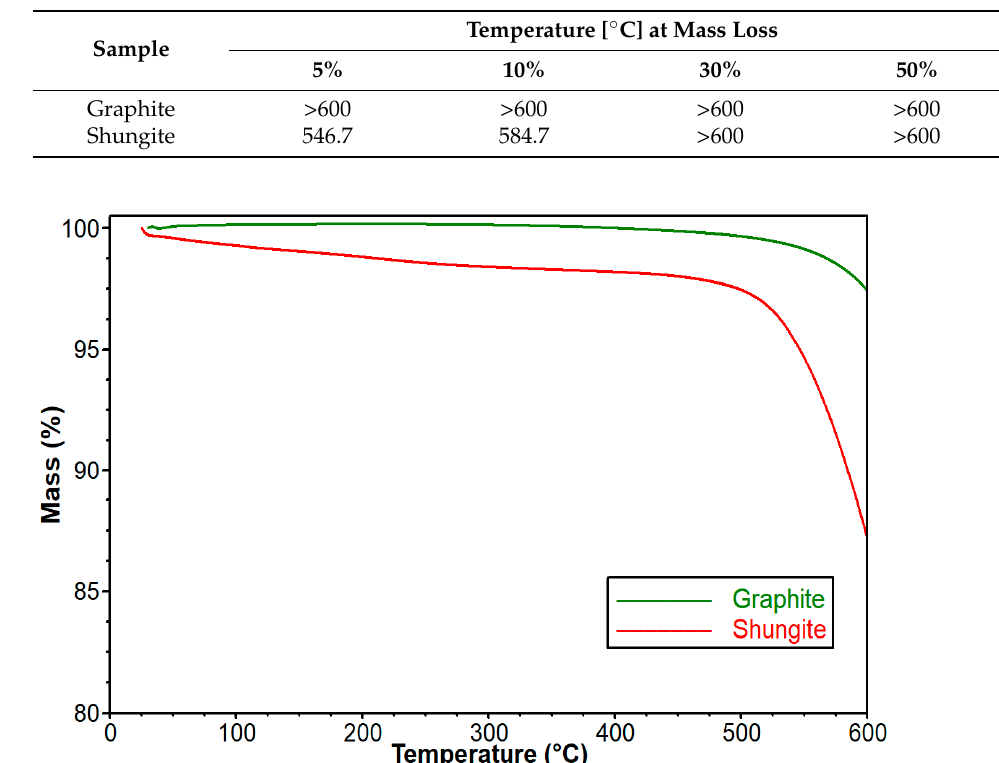
Table 3. Thermal stability of used carbonaceous fillers.